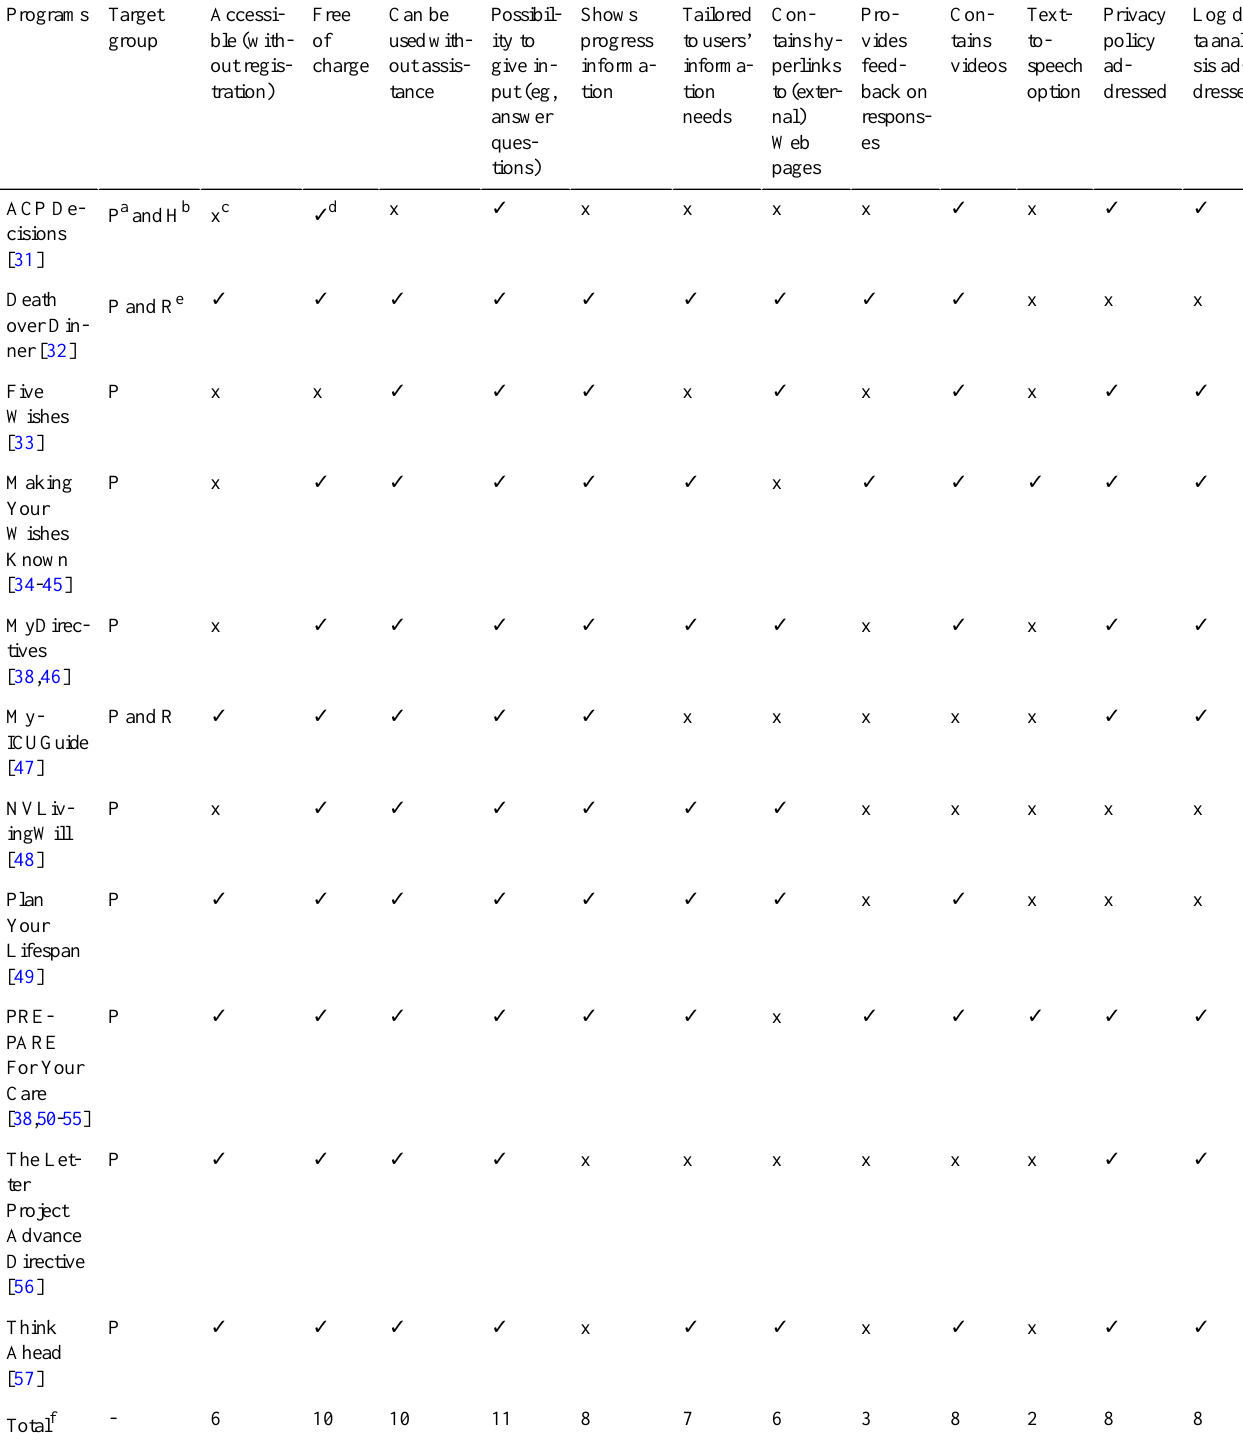
Table 1. Functionalities of the Web-based advance care planning